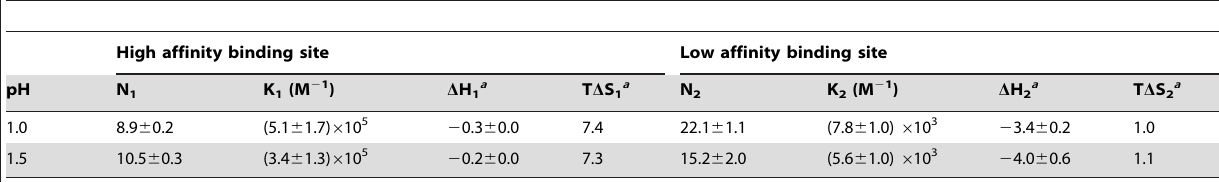
Table 3. Number of moles and thermodynamic parameters for binding of 1-anilino-8-naphthalene sulfonate (ANS) to chymopapain at different